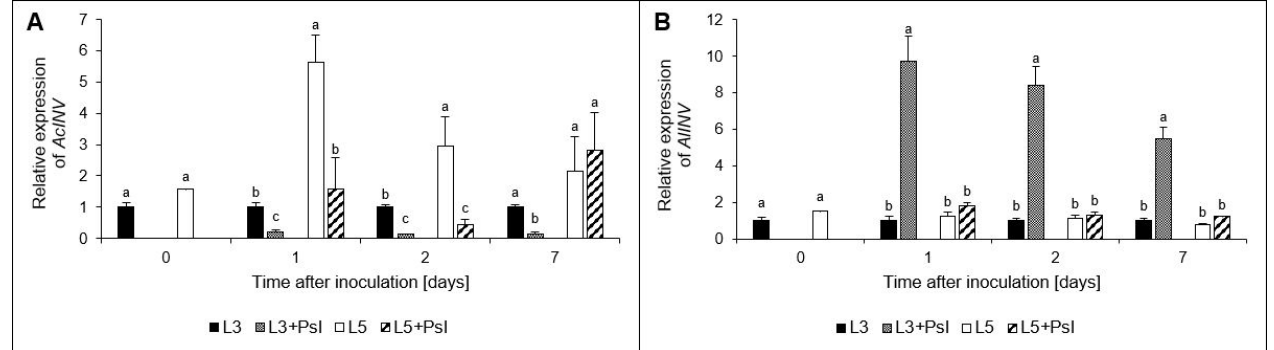
Figure 3. Relative expression of ( A ) acid invertase ( AcINV ) and ( B ) alkaline invertase ( AlINV ) genes in cucumber leaves after P. syringae pv lachrymans infection. Values are means of four replicates ( ± SD). Different letters (a–c) indicate significant ( p ≤ 0.05) differences between experimental variants at a given time point.